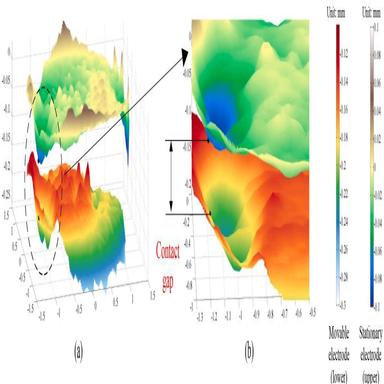
Geometries of electrode pair. (a) The position of data points with the minimum height difference. (b) Zoom region around the electrode gap points.